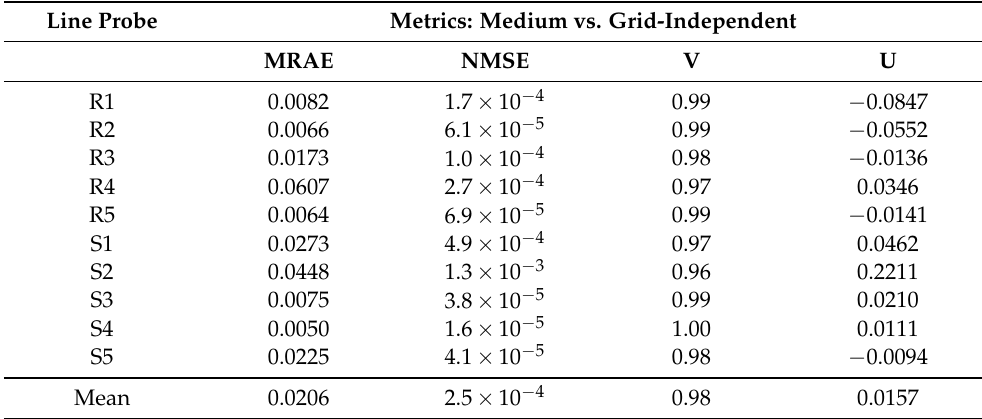
Table 5. Verification metrics for results on the medium grid and the estimated exact